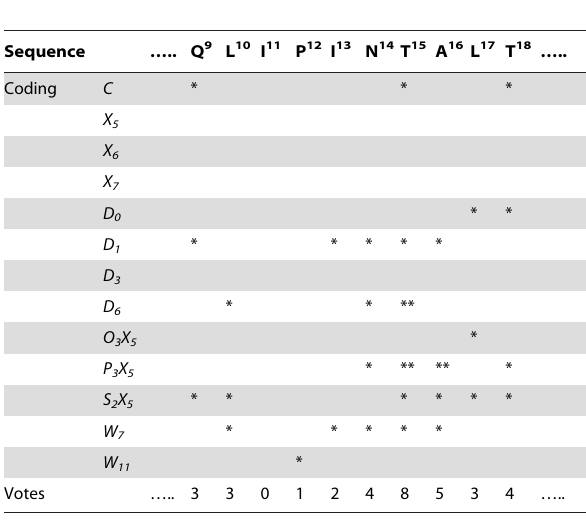
Table 5. An example of votes acquired by residues in a sequence from 1msi.